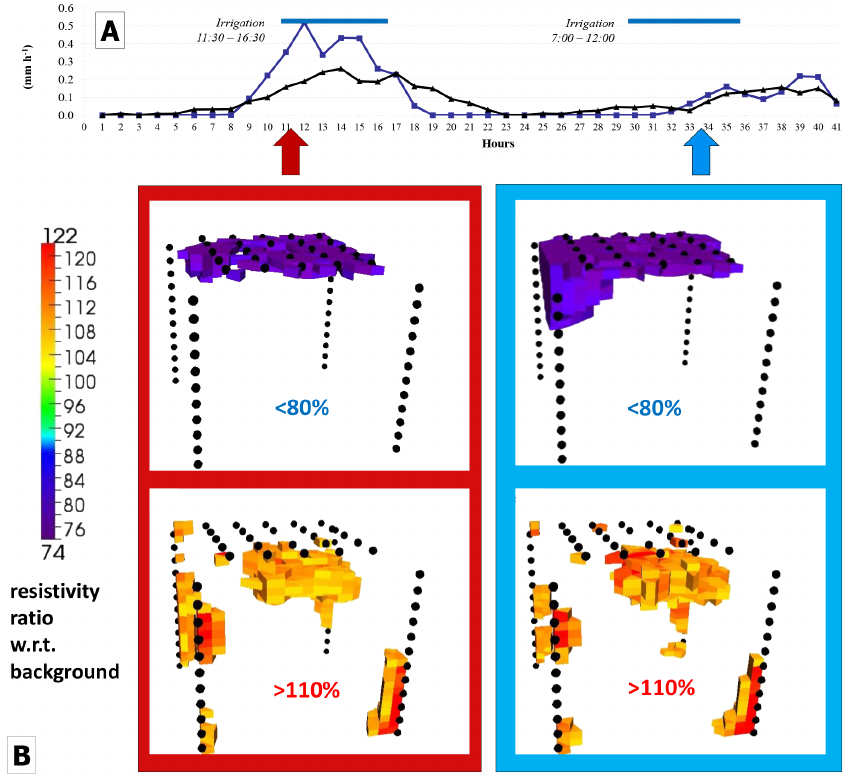
Figure 5. (a) Time series of sap flow (black line) and EC-derived total evapotranspiration (blue lines), both normalized in millimetres assuming an area of 20m 2 pertaining to the orange tree monitored with ERT. Time is given in hours from midnight of 2 October. The two irrigation periods are shown by the blue bars. (b) 3-D ERT images of resistivity change with respect to background at two selected time instants shown by the arrows in (a) ; the volumes corresponding to increase and decrease of resistivity above and below certain thresholds (80 and 110%) are shown in separate panels, for